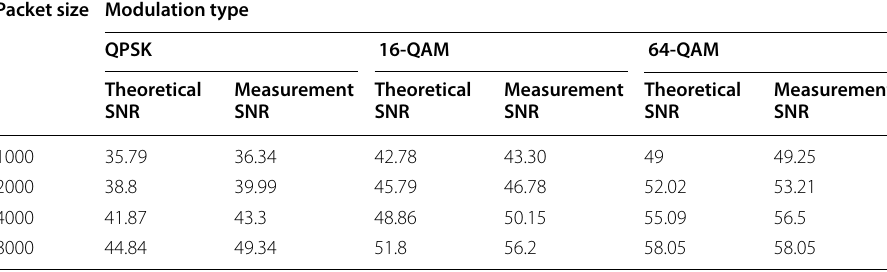
Table 2 Theoretical and practical SNR values for different packet